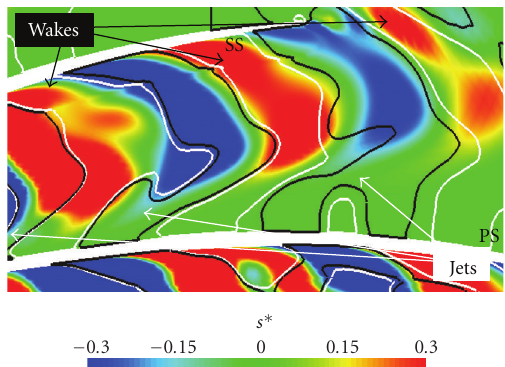
Figure 16: Color map of the reduced unsteady entropy, black/white contours: migration toward shroud/hub at a given time step, at midsection height.